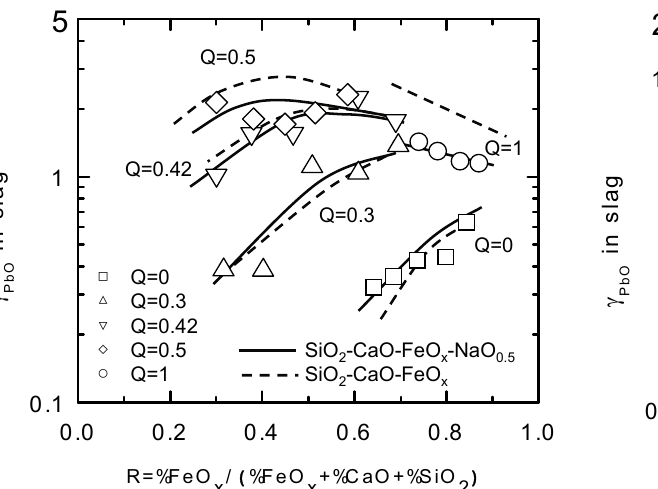
Figure 7. The activity coefficient of PbO in the CaO-SiO 2 - FeO x -5mass%CrO 1:5 slag at 1573 K.